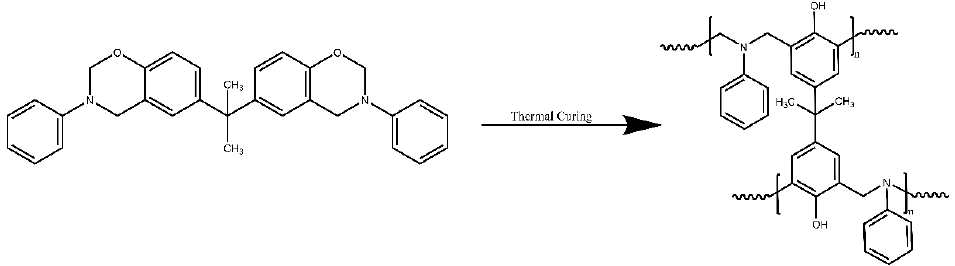
Figure 1. Thermally induced ring-opening polymerization of benzoxazine.